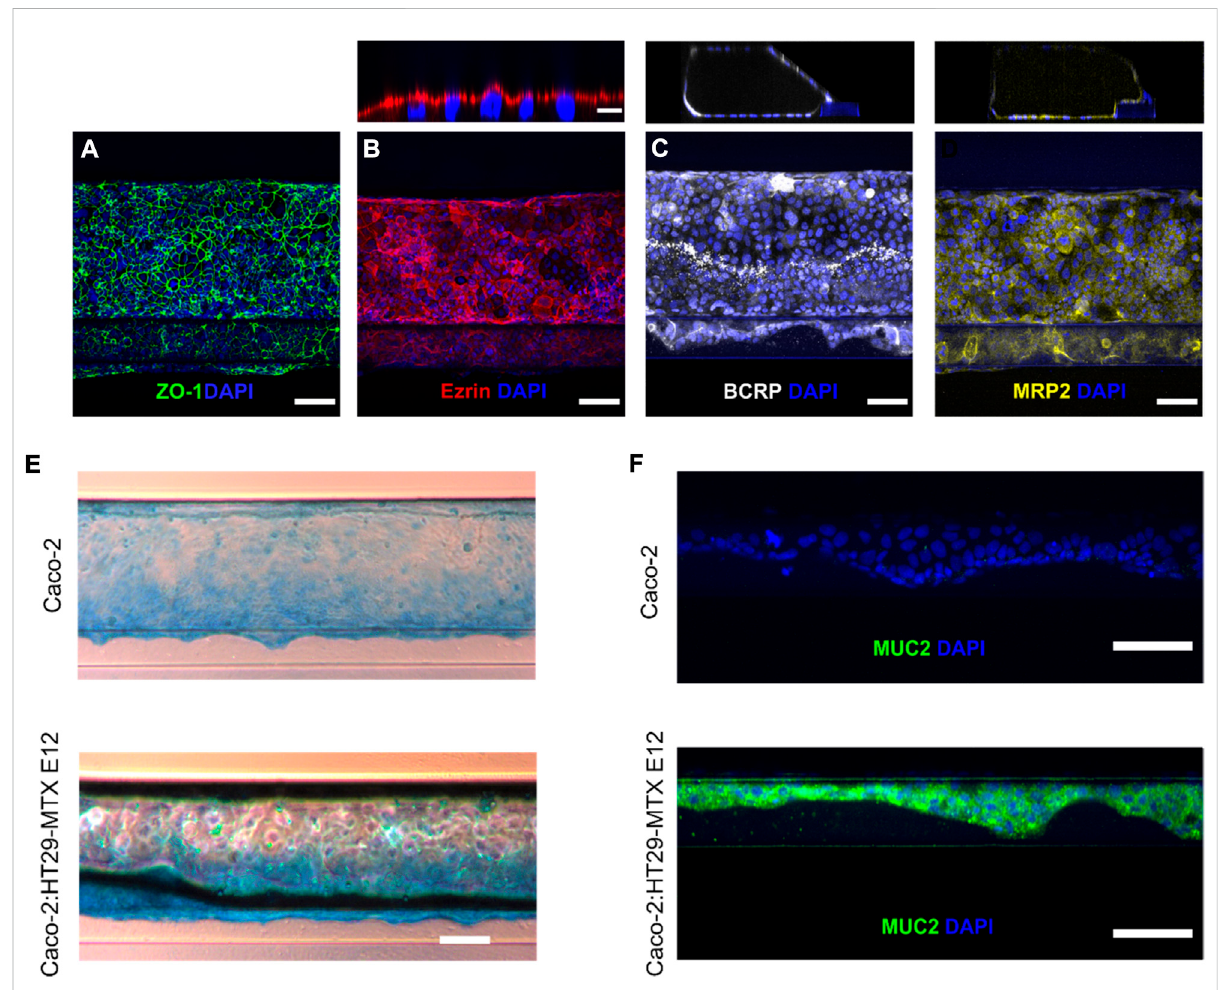
FIGURE 2 Veri fi cationofadifferentiatedandpolarizedepithelialmonolayerusingdirectin-chipimmunostaining. (A) Tightjunctionformationdepictedby maximum intensity projection (MIP) from confocal z-stack of ZO-1 (green) and DAPI (blue) (scale bar is 100 µm). (B) Bottom, brush borders are visualized as MIP from confocal z-stack of ezrin (red) and DAPI (blue) (scale bar is100 µm). Top, theapical orientation ofezrinexpressionis depicted as a vertical cross-section of the cell-tubule (Scale bar is 10 µm). (C) Bottom, BCRP ef fl ux transporter (white) and DAPI (blue) are visualized as MIP from confocal z-stack (scale bar is 100 µm). Top, A vertical cross section of the BCRP stained cell-tubule. (D) Bottom, MIP ofcell-tubule stained for the ef fl ux transporter MRP2 (yellow) (scale bar is 100 µm). Top, vertical cross section of the MRP2 stained cell-tubule. (E) Bright fi eld microscopy images showing Alcian Blue staining of acidic mucins in mono- (top) and coculture (bottom) tubules (scale bar is 200 µm). (F) Micrograph of single z-slice of the cell layer along the ECM interface for mono- and coculture depicting Muc2 (green) and DAPI (blue) (scale bar is 100